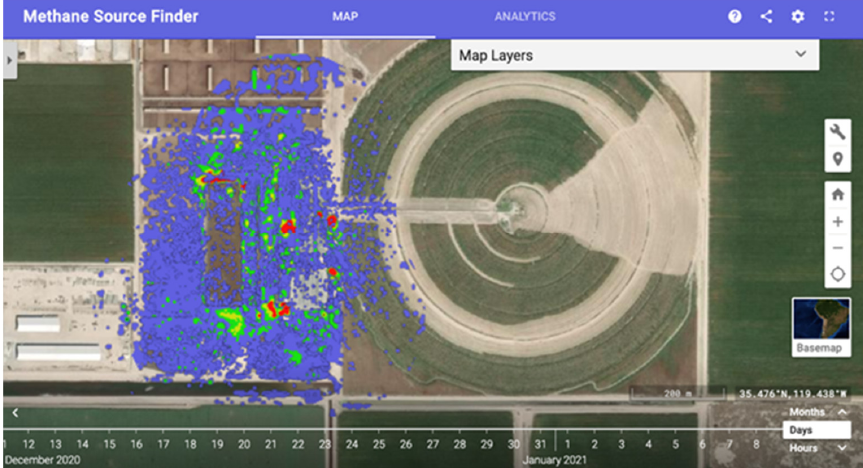
Figure 6. Methane Source Finder: An interactive map of methane data in California developed from AVIRIS imaging spectroscopy data [107].